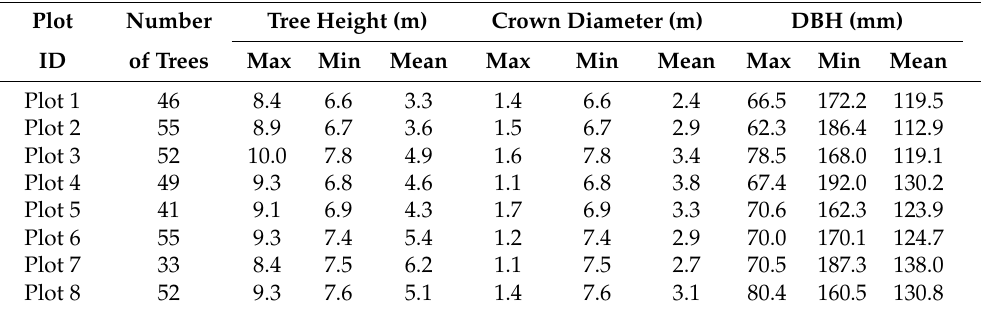
Table 1. Basic statistics of the reference height, the reference crown diameter, and reference stem diameter breast height (DBH) of trees in the eight circular plots with varying degree of complexity, considered for the performance evaluation of the S3-ITD.